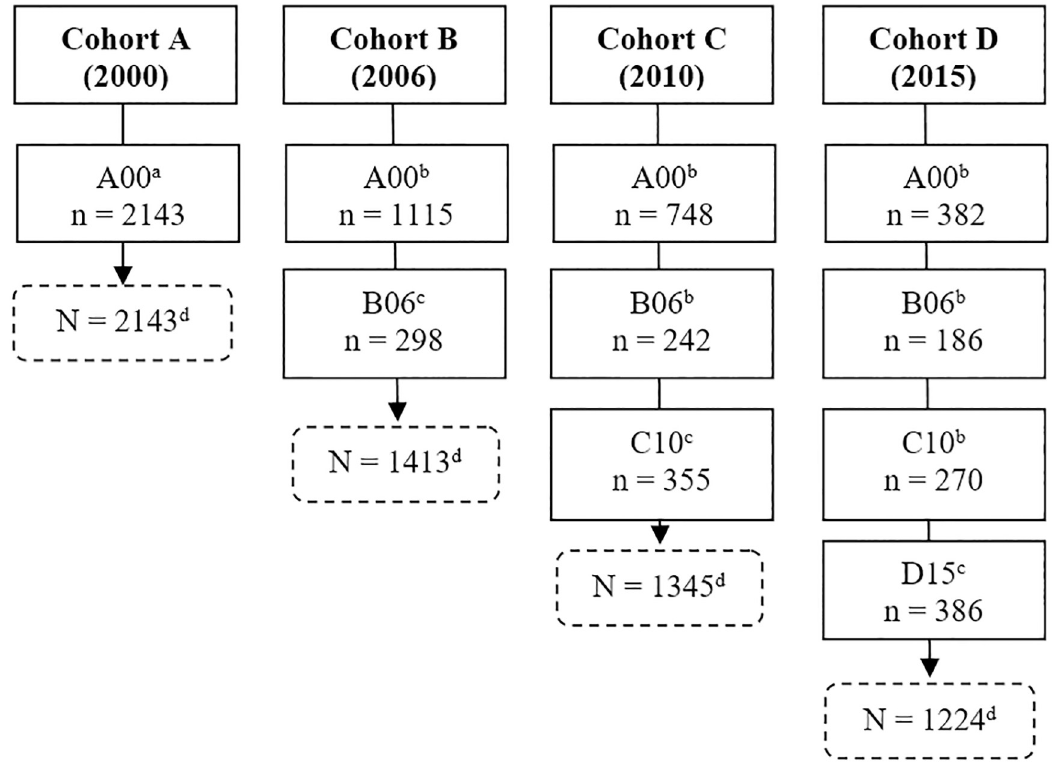
Fig 1. Sample distribution of the SABE Study, years 2000, 2006, 2010 and 2015. S ã o Paulo-Brazil. a Primary sample. b Reinterviewed elderly. c Elderly people aged 60 to 64 included. d Number of elderly in each